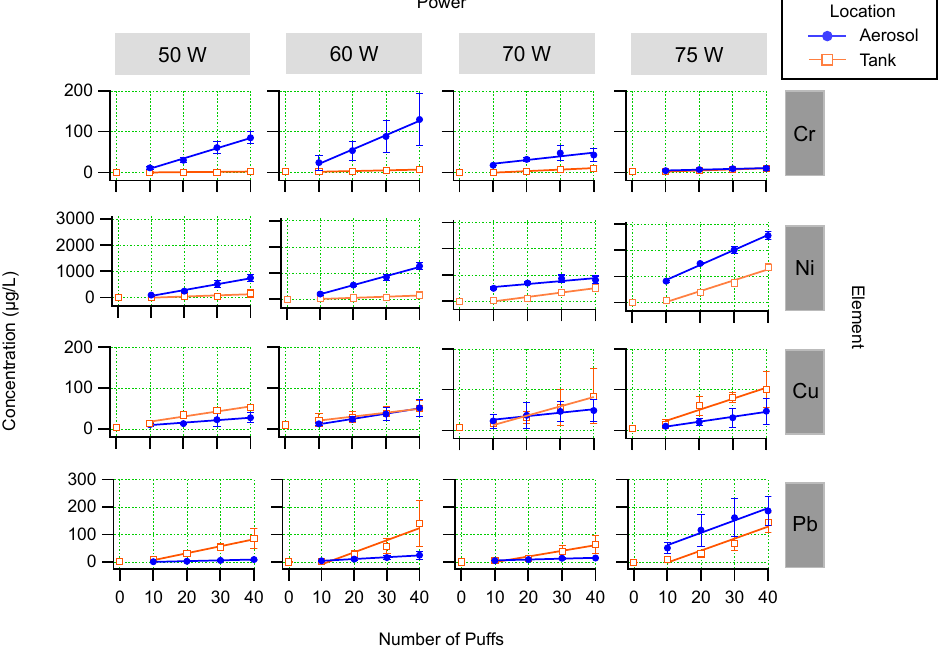
Figure 3. Results. Solid blue circles represent the concentrations in the collected aerosol and open orange squares represent the concentrations in the tank liquid. Note the varying vertical axes for different metals. Error bars are ± the standard deviations of three independent puffing